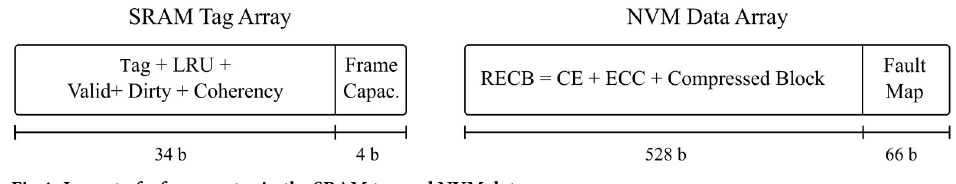
Fig 4. Layout of a frame entry in the SRAM tag and NVM data